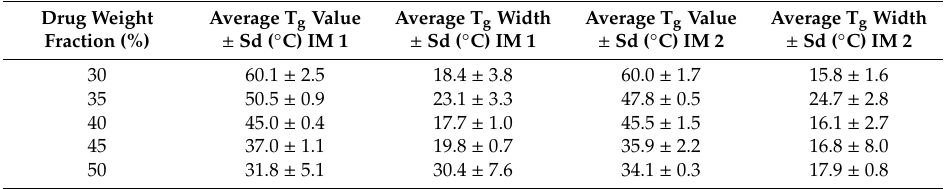
Table 3. Average T g values and widths ± sd for MIC-PVP-VA surface coated tablets, using the